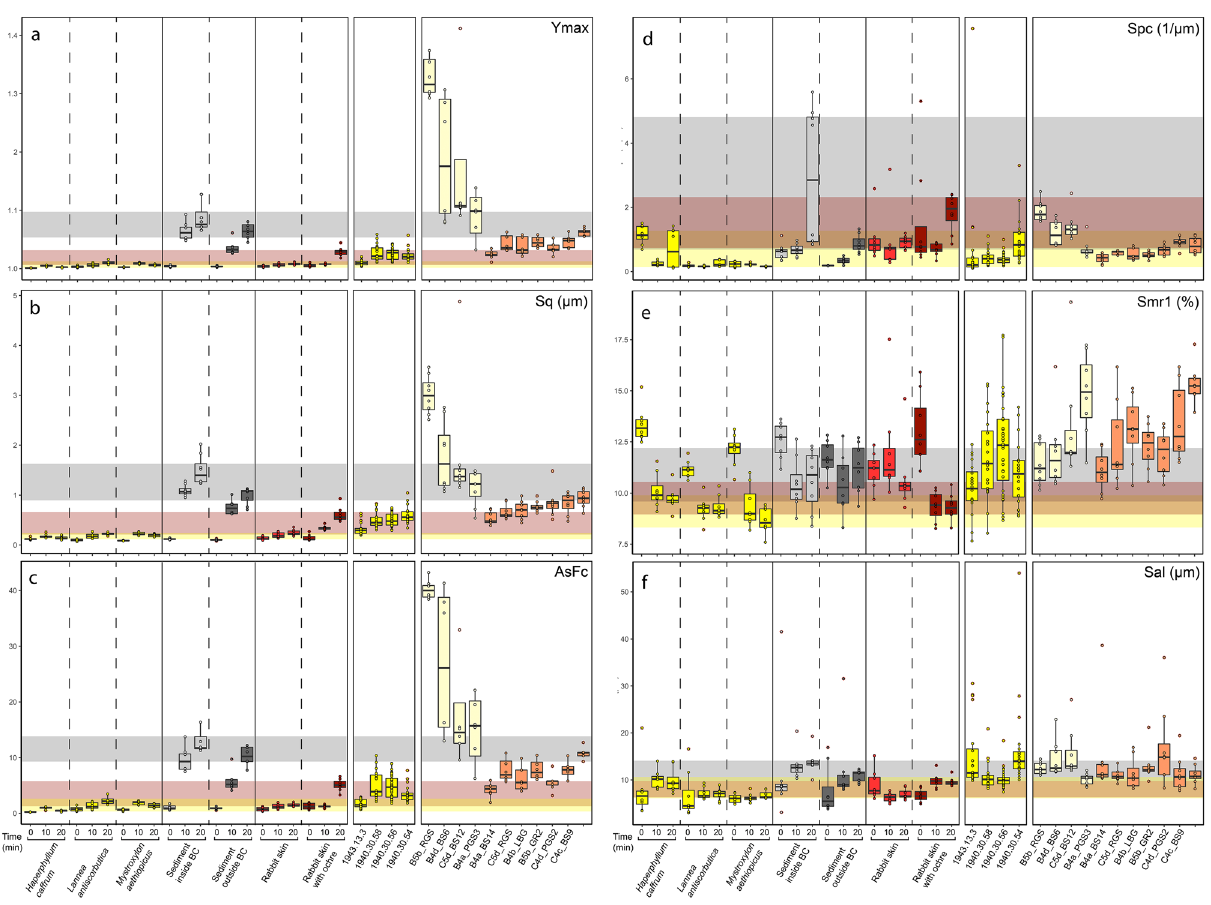
Figure 6. Texture analysis. Boxplots illustrating the variability in textural parameters Ymax ( a ), Sq ( b ), AsFc ( c ), Spc ( d ), Smr1 ( e ), and Sal ( f ) on experimental double-beveled tools used, from left to right, in debarking southern African trees, digging in dry sediment and humus-rich soil, and processing rabbit skin with/without ochre, and on ethnographic debarkers as well as on unworn and worn archaeological specimens found at the Sibudu site. Vertical dashed lines separate tools used on different tree species, types of sediment, and presence/ absence of ochre mixture for processing rabbit pelt. Numbers on experimental tools indicate length of use in minutes. Horizontal colored bands highlight the range of variability at 1σ for each experimental function (debarking in yellow, digging in sediment in grey, processing pelt in red) after 20 min of use. Mixed colors indicate overlap between ranges. BC = Border